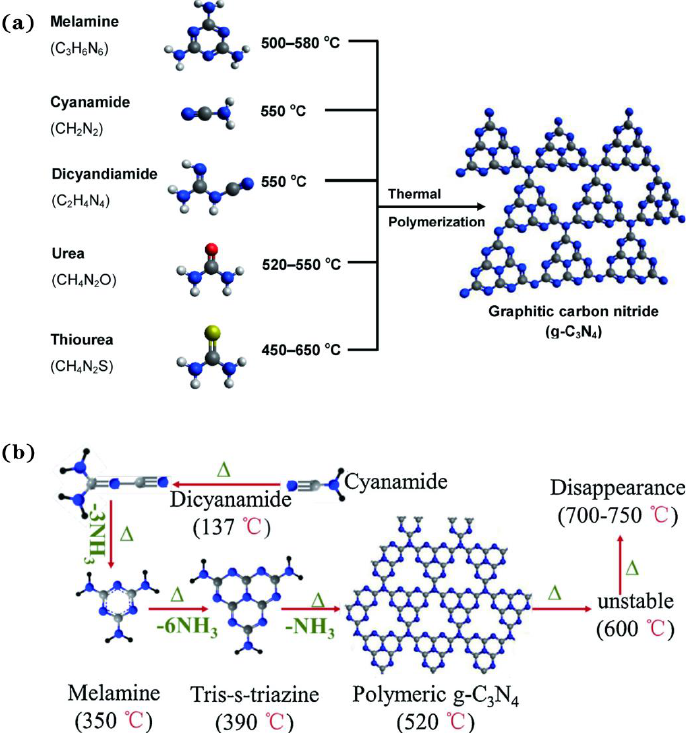
Figure 2. ( a ) Synthesis of g − C 3 N 4 using thermal polymerization with different precursors [32]. Copyright 2016, American Chemical Society. ( b ) reaction pathway of g − C 3 N 4 using cyanamide as a precursor [38]. Copyright 2017, Elsevier.